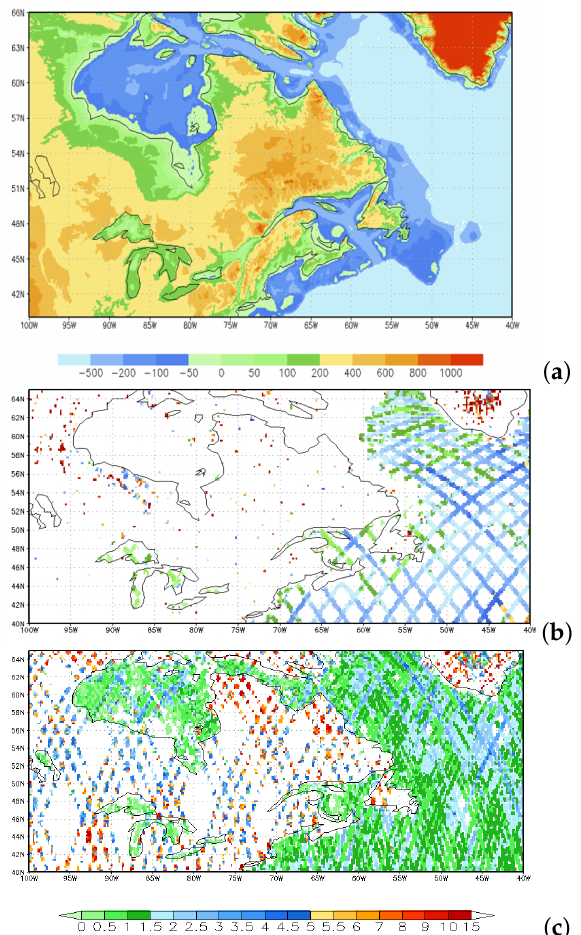
Figure 11. Availability of SWH data over very shallow depth from SARAL/Altika as compared to Jason-2. The example is Hudson Bay, with average depth of 100 m and maximum depth of 270 m: ( a ) bathymetry of Hudson Bay; ( b ) SWH from Jason-2; and ( c ) SWH from